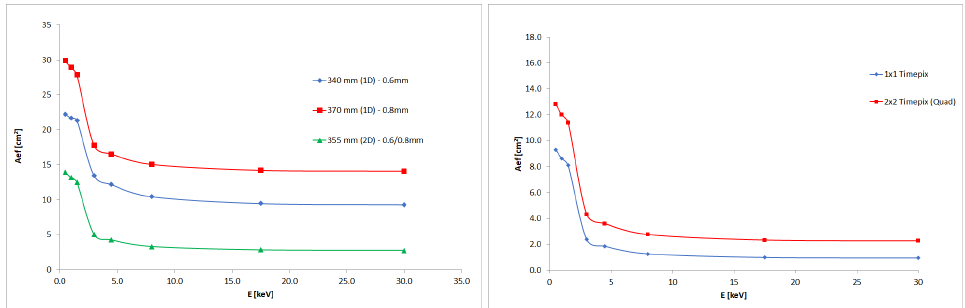
Figure 4. Lobster Eye (LE) effective area including direct beams ( left ); effective area of the spot ( right ). Simulations were performed for LE optics module, where first module (1 reflection) of 340 mm focal length and spacers (distances between foils) of 0.6 mm are used. Similarly, results for second 1D module of 340 mm focal length and spacers (distances between foils) of 0.8 mm are used. For full 2D system combining both modules are presented. Analysis uses reflection properties from Figure 6 layer D, 2 nm POLY variant (nonperiodic multilayer on Au basis).